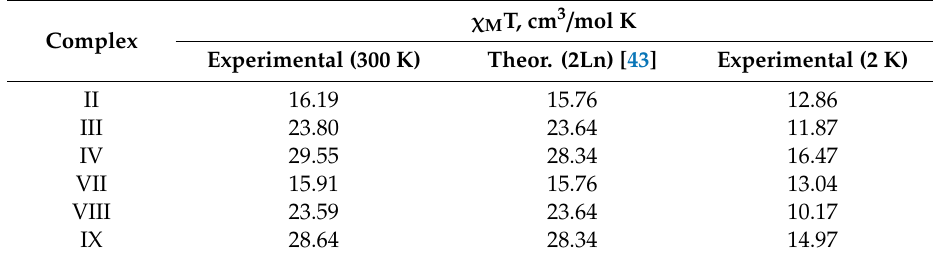
Table 5. Approximation parameters of χ M T(T) dependences for complexes II and VII calculated by means of the PHI program [44].